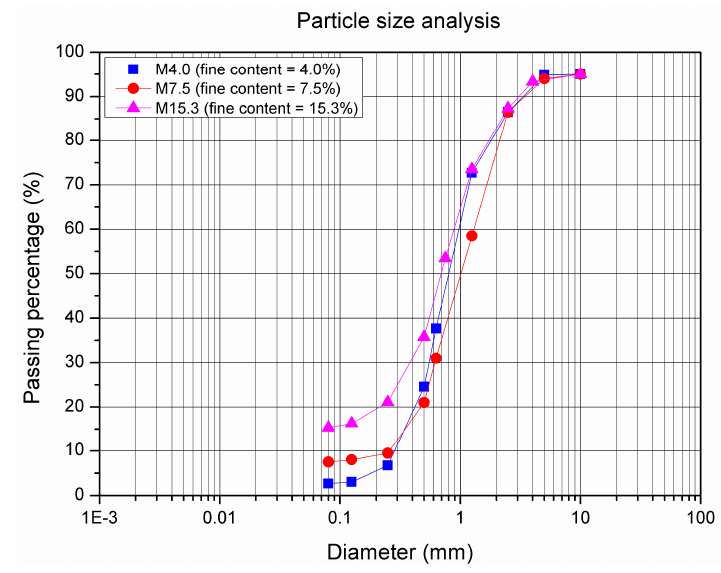
Figure 1. Particle size distribution curves of Missillac sand (M4.0, M7.5 and M15.3).